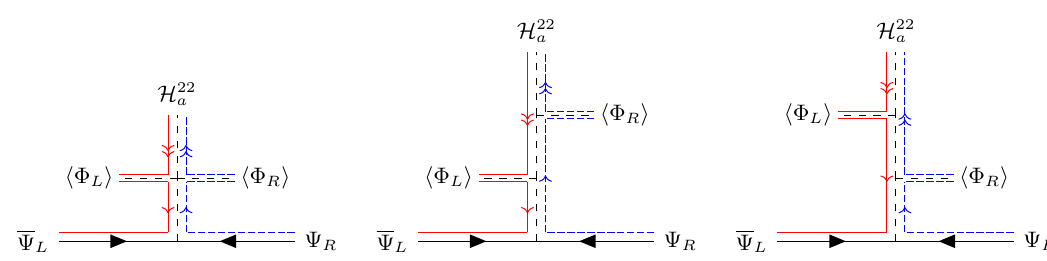
. The presence of 12